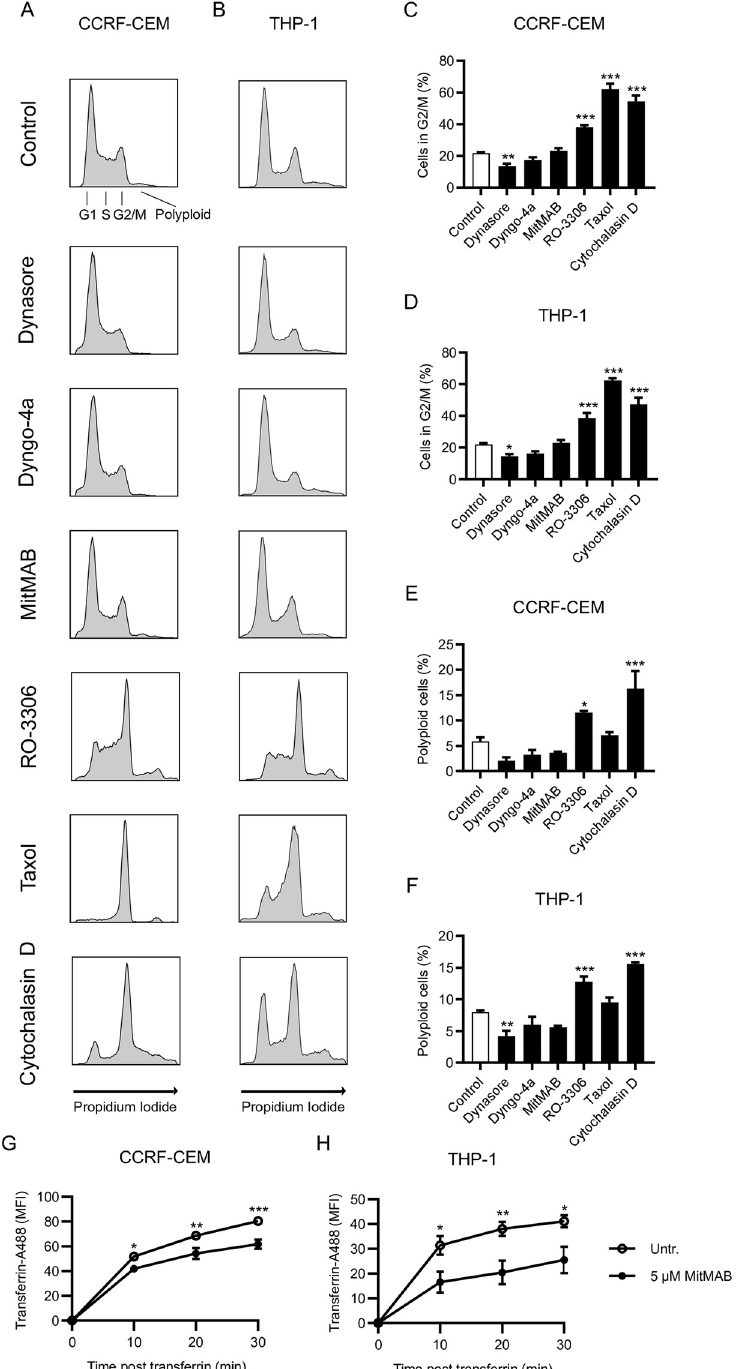
Fig 6. Dynamin inhibition affects transferrin uptake but not cell cycle progression in leukemia cells. (A-B) 0.15 x 10 6 CCRF-CEM (A) or THP-1 (B) cells/ml were cultured for 18 h with either 40 μ M Dynasore, 10 μ M Dyngo-4a, 5 μ M MitMAB, 10 μ M RO-3306, 0.5 μ g/ml Taxol, or 2 μ g/ml Cytochalasin D as indicated. Cell cycle profiles were analyzed (see experimental procedures for details). Gating for different cell cycle phases: G1 (gap phase 1), S (DNA synthesis phase), G2/M (gap phase 2 or mitosis), as well as polyploid cells are shown in the upper left panel in (A). (C-F) Quantification of the proportion of cells in G2/M phase and polyploid cells as indicated. (G-H) Effect of MitMAB (5 μ M) on the uptake of fluorescent transferrin by CCRF-CEM (G) and THP-1 (H) cells. Time point “0” indicates unstained samples. Data are given as mean + SEM, containing 4–6 pooled replicates from 2–3 independent experiments. Two-way ANOVA was used for statistical testing including Dunnett’s posthoc test for (D-F).